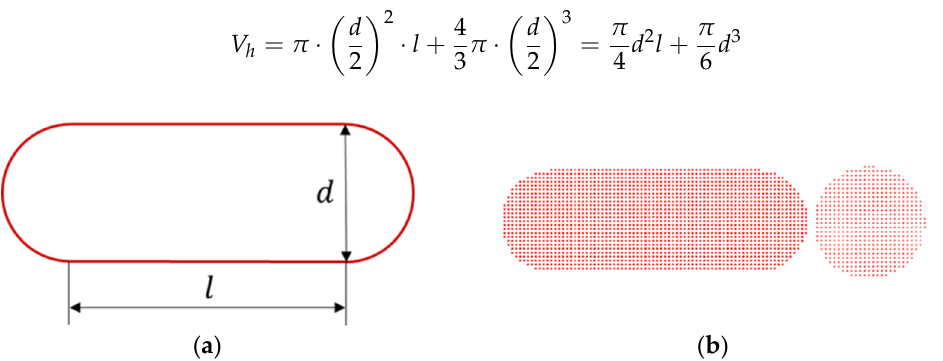
Figure 1. The hemispherical-ended cylinder model: ( a ) Geometric model; ( b ) SPH model.